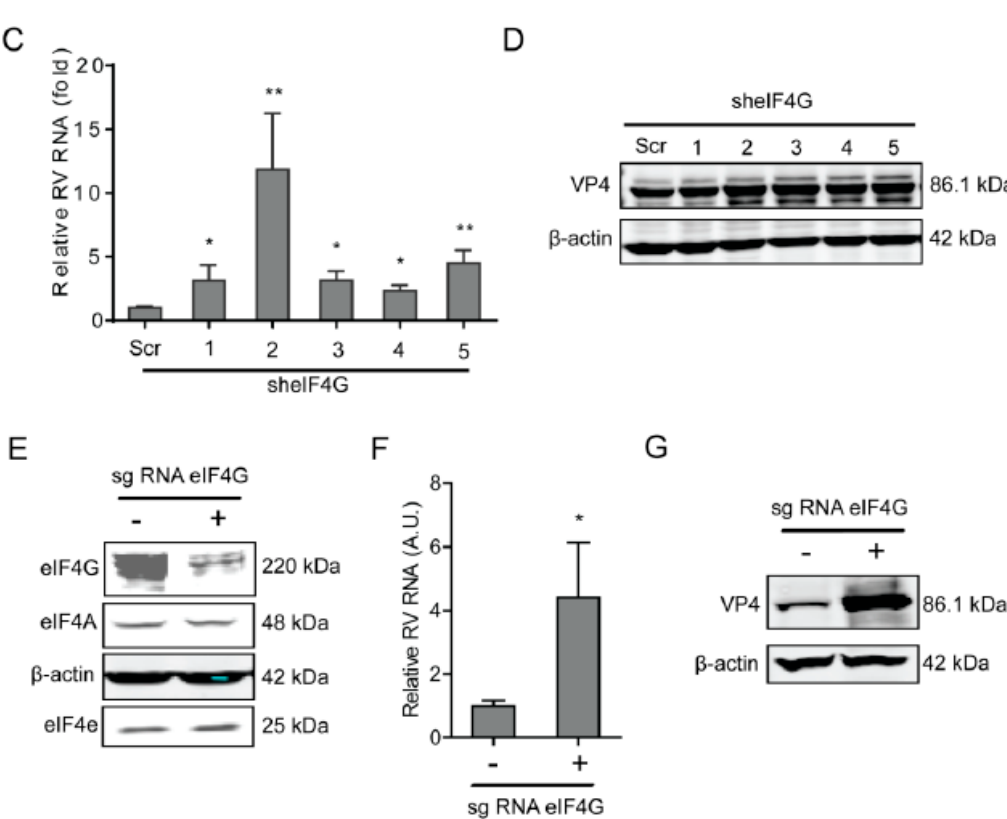
Figure 3. Silence of eIF4G promotes rotavirus infection. ( A ) Western blot assay detected eIF4G in Caco2 cells transduced with lentiviral RNAi vectors against eIF4G. ( B ) Successful knockdown by shRNA vectors detected by RT-qPCR assay ( n = 6, *** P < 0.001, Mann–Whitney test). ( C ) Silence of eIF4G showed an increased rotavirus genomic RNA level ( n = 6, * P < 0.05, ** P < 0.01, Mann–Whitney test). ( D ) Silence of eIF4G promoted the viral VP4 protein level in SA11 rotavirus infected Caco2 cells. ( E ) Western blot assay detected eIF4G in Caco2 cells transduced with CRIPSRs against eIF4G. ( F ) Silence of eIF4A by CRISPR/Cas9 increased the rotavirus genomic RNA level ( n = 6, * P < 0.05, Mann–Whitney test). ( G ) Silence of eIF4G by CRISPR/Cas9 increased the viral VP4 protein level in SA11 rotavirus infected Caco2 cells.